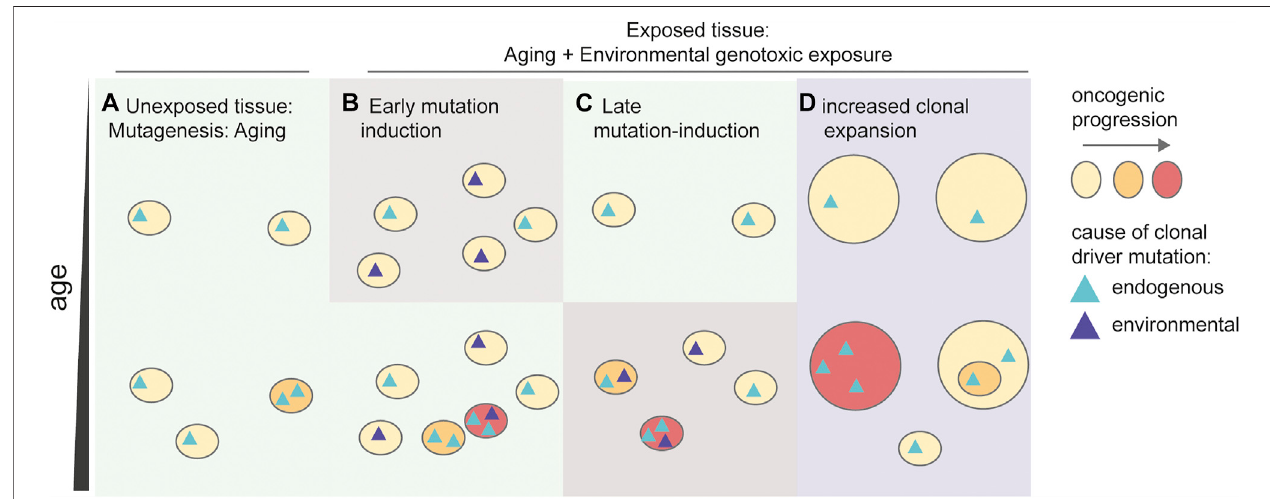
FIGURE 3 | In fl uence of environmental genotoxins in the development of cancer. Schematic depicting multiple possible mechanisms responsible for an increased risk on developing cancer. (A) Aging drives a general mutation accumulation, inducing early driver mutations, which drive clonal expansions. These age-related clonal expansionsinduceanincreasing,butrelativelylowriskondevelopingcancerduringaging. (B) Earlymutagenesisinducesadditionalclonescontainingdrivermutationsin the tissue. An increased number of driver-containing clonal expansions increases the chance of acquiring additional driver mutations resulting in malignant cancer (red). (C) Late mutagenesis by environmental factors induces additional mutations in pre-existing oncogenic clones resulting in malignancies (red). (D) Exposure to the environmental factor results in preferential selection of driver-containing clones. The enhanced size of the clones increases the chance of acquiring additional driver mutations, resulting in